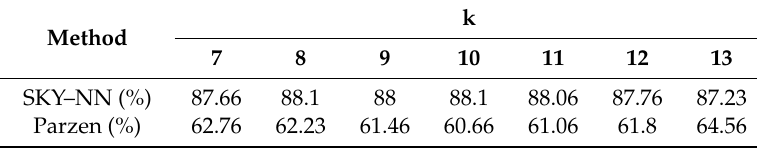
Table 27. Smart skyline on the real